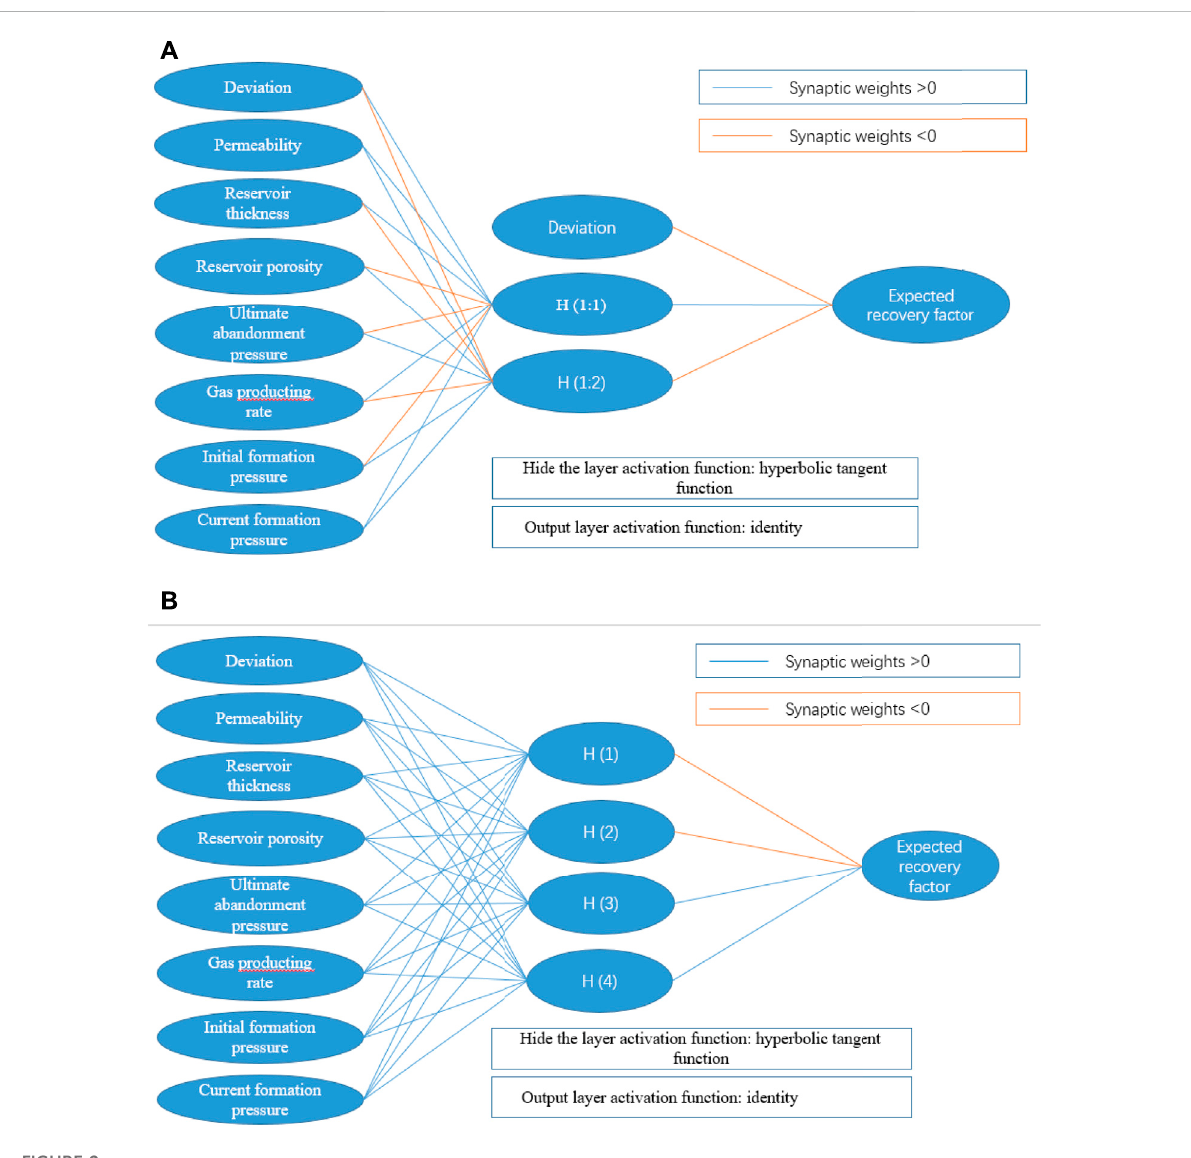
FIGURE 2 Prediction neural network model of gas reservoir recovery. (A) Multilayer perceptron. (B) Radial basis